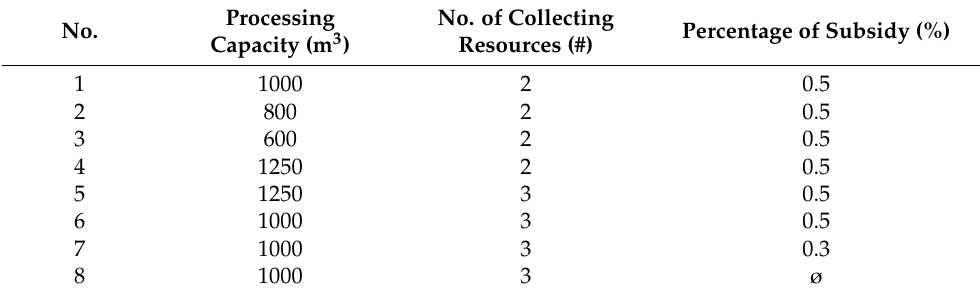
Table 7. The eight (8) scenarios